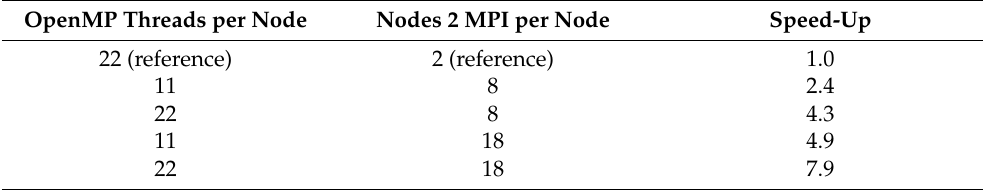
Table 5. Case study 2: speed-up values for task d with OpenMP–MPI on MARCONI Cluster. OpenMP Threads per Node Nodes 2 MPI per Node